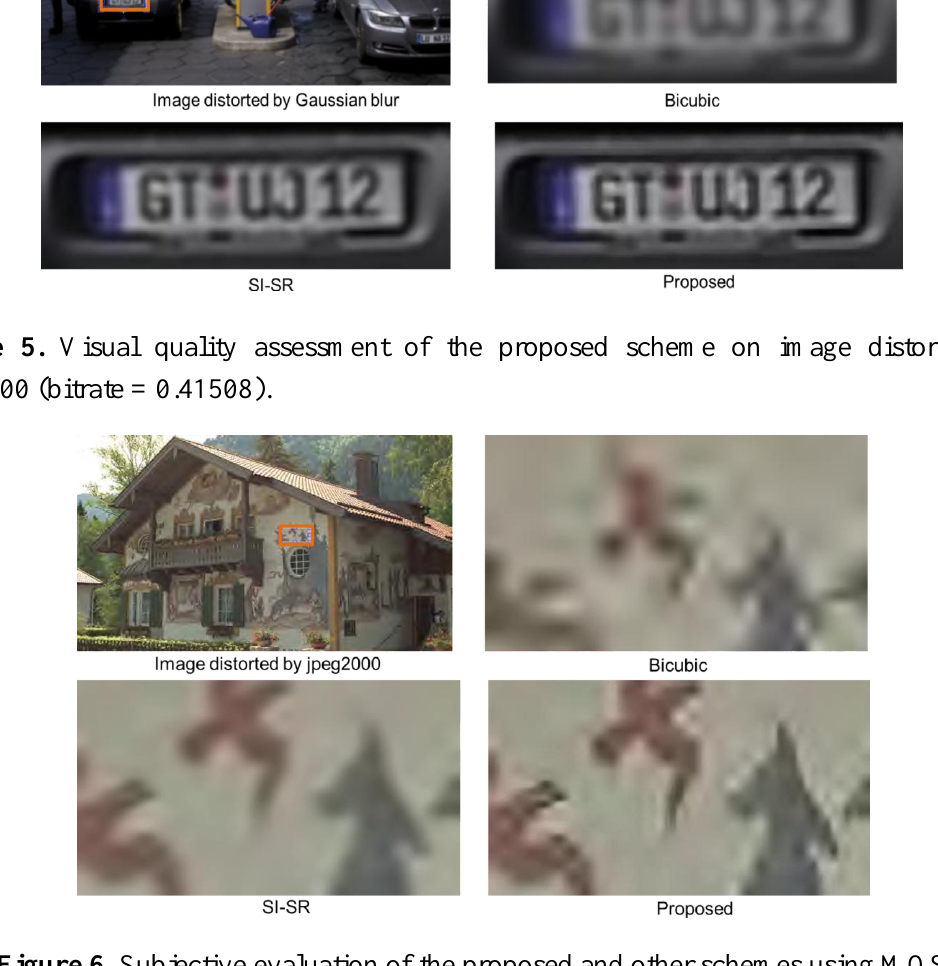
Figure 6. Subjective evaluation of the proposed and other schemes using